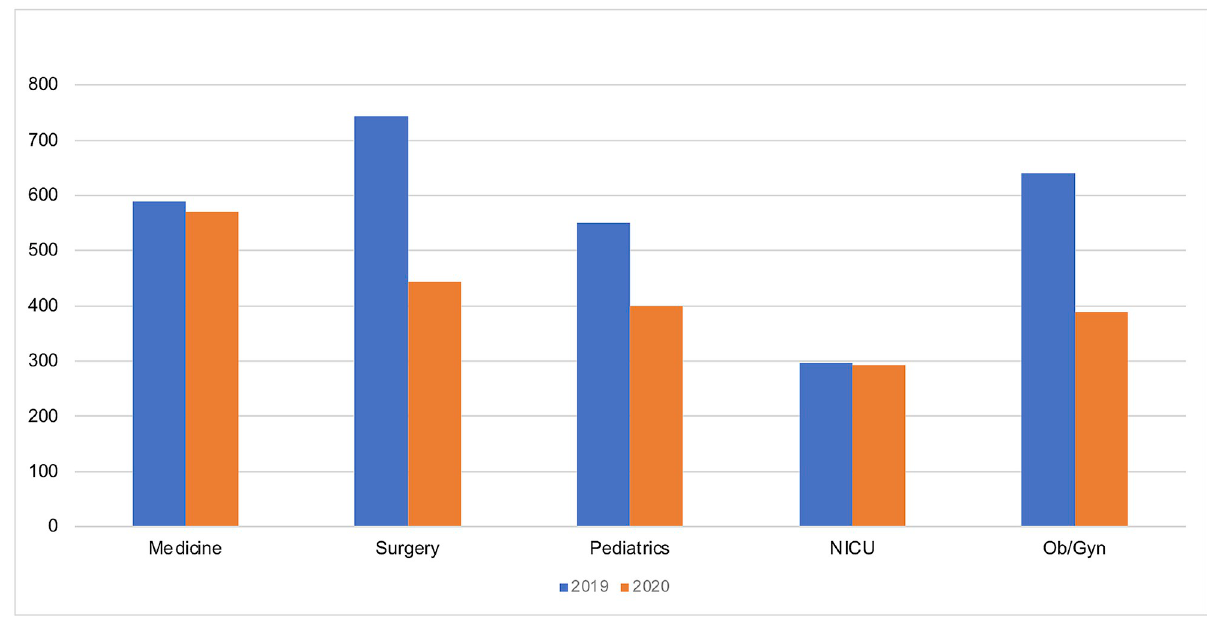
Fig 4. Frequency of crossmatch requests by department in 2019 (blue) and 2020 (orange). NICU: Neonatal intensive care unit; Ob/Gyn: obstetrics and